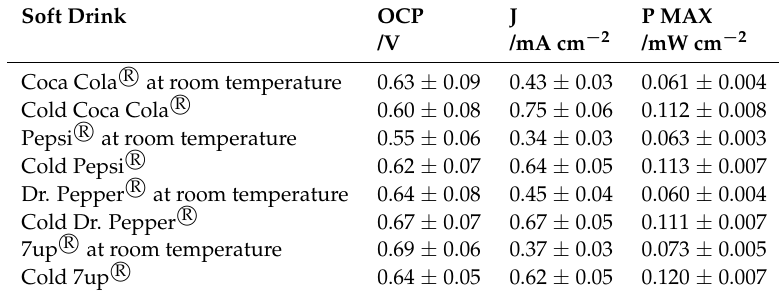
Table 2. Experimental parameters obtained from the overall performance of the paper-based µ FCs with different soft drinks as fuels. Results are expressed as mean values (n = 3) ± standard